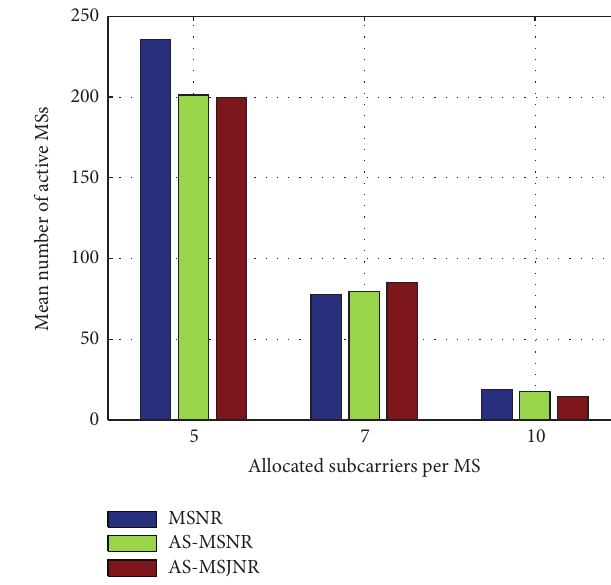
Figure 6: Mean number of active MSs for 16-QAM modulation and one tier of cells around the central